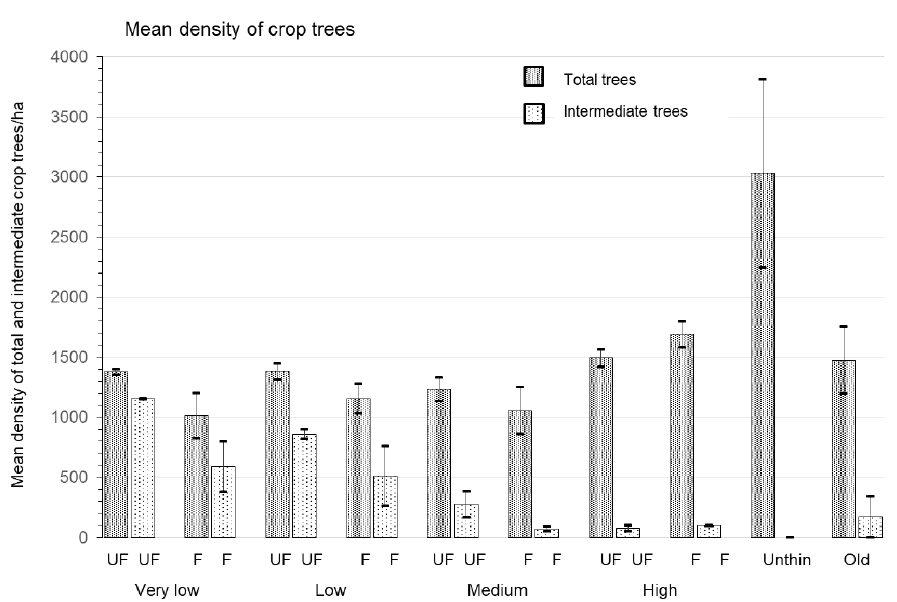
Figure 4. Mean ( n = 2,3 replicate study areas; ± SE) density/ha of total crop trees and intermediate (ingress) crop trees in the very low-, low-, medium-, and high-density stands of lodgepole pine with (F) and without (UF) fertilization, and in unthinned (Unthin) and old-growth (Old G) stands, 25 years after initiation of treatments. Table 3. Mean ( n = 2 replicate study areas) ± SE 25-year responses (1993 to 2018) of overstory and understory attributes for young lodgepole pine stands among four post-thinning (PCT) densities and two fertilization (FERT) treatments. Results of analysis of variance (ANOVA) are provided. Within a row, mean values with different letters are significantly different by Duncan’s multiple range test. Significant values in bold. ANOVA Density Fertilizer Density ×